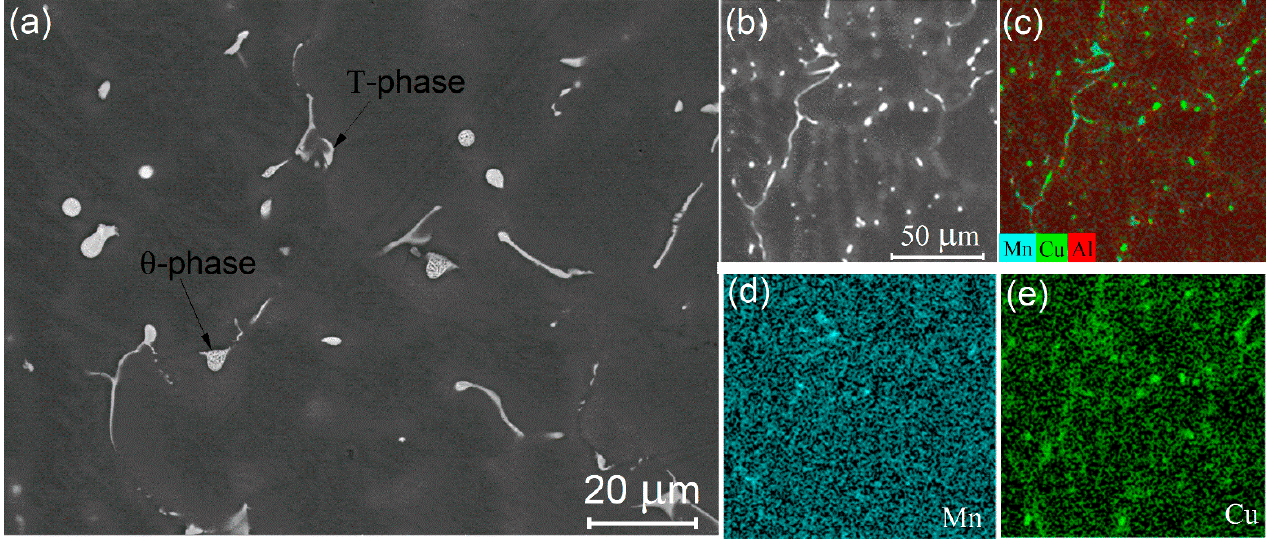
Figure 2. ( a , b ) The as-cast microstructure of the Al-2%Cu-2%Mn alloy, ( c ) EDS layered image, ( d ) Mn-distribution map, and ( e ) Cu distribution map for image in ( b ).